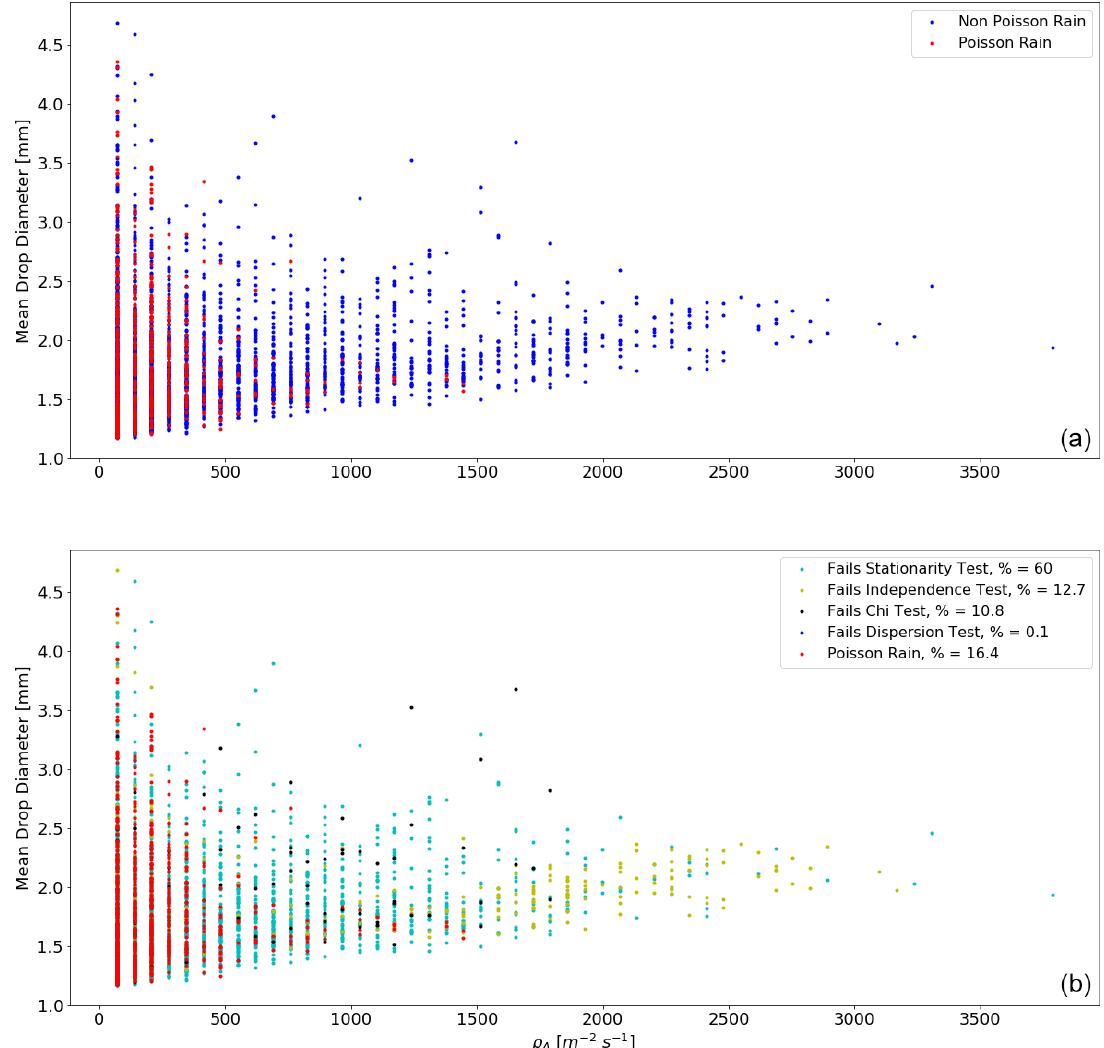
Figure 9. Trends in mean drop size for Poisson and non-Poisson rain are presented as well as the percentage of drops that fail each of the Poisson tests. Panel (a) differentiates between Poisson and non-Poisson rain. Panel (b) is further subdivided to show which of the Poisson tests each data point